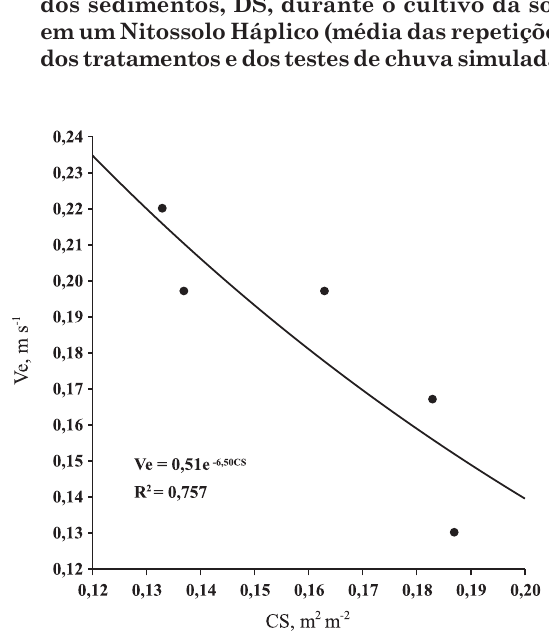
Figura 4. Relação entre a velocidade da enxurrada, Ve, e a cobertura do solo por resíduos culturais, CS, nos testes de chuva simulada durante o cultivo da soja em um Nitossolo Háplico (média das repetições e dos